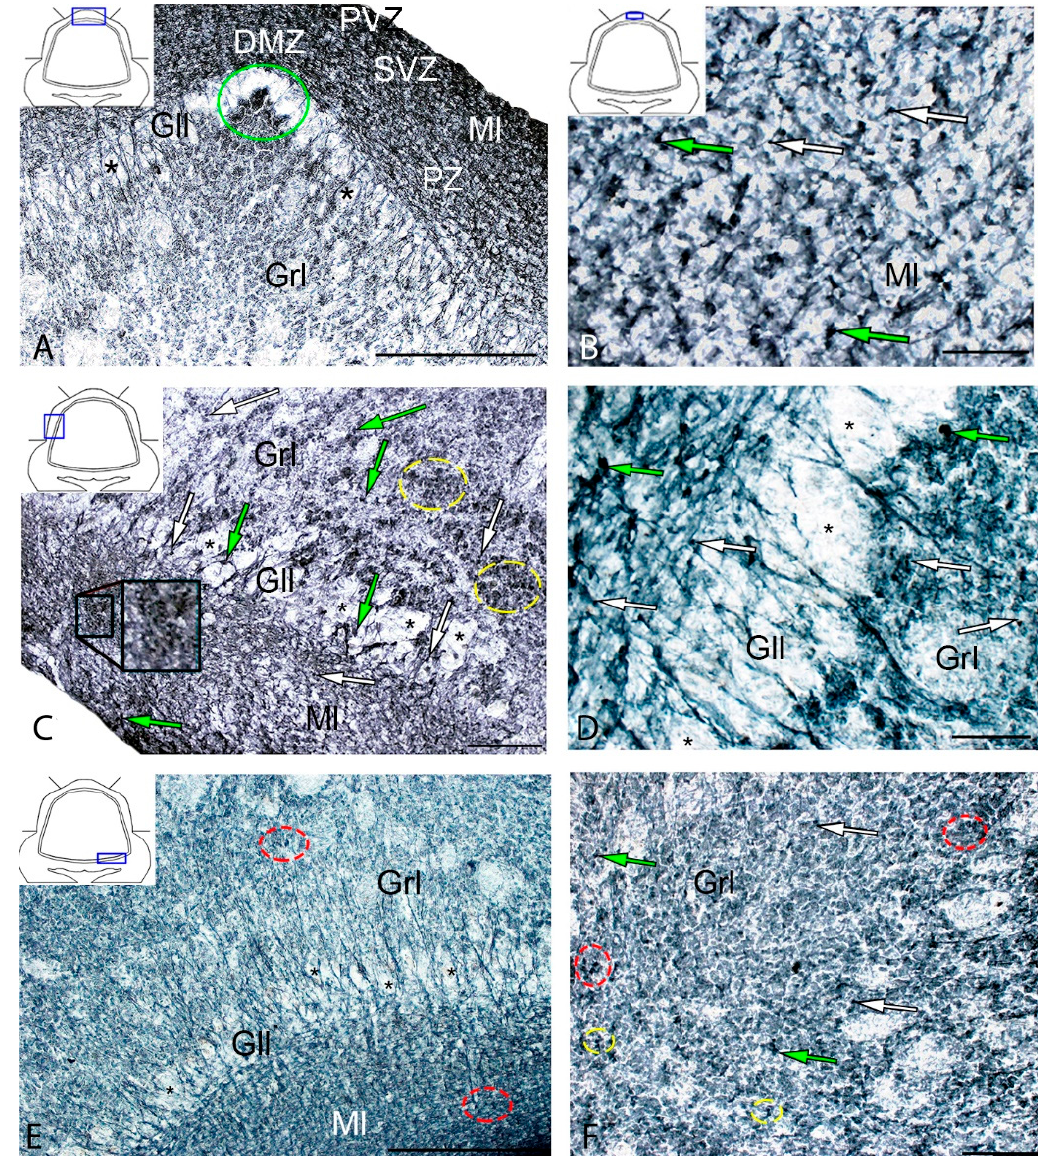
Figure 11. Distribution of cystathionine- β -synthase (CBS) in the intact cerebellum of juvenile masu salmon, Oncorhynchus masou . ( A ) General view of DZ: CBS − cells are indicated by asterisks; DZM is outlined by green oval. ( B ) DZ, molecular layer: CBS + type 1 cells (white arrows); CBS + type 2 cells (green arrows); periventricular zone (PVZ), subventricular zone (SVZ), parenchymal zone (PZ). ( C ) LZ, see designations in Figure 11A: aggregation of CBS + cells in the parenchymal part of the molecular layer (black inset); aggregation of CBS + cells in the granular layer (yellow dashed oval). ( D ) Ganglionic layer: CBS − cells are indicated by asterisks, see designations in Figure 11A. ( E ) Basal zone: CBS − cells are indicated by asterisks; clusters of CBS + cells (red dashed oval). ( F ) Granular layer; clusters of CBS + cells (red dotted oval); paired cells (yellow dotted oval). IHC labeling with CBS. The blue rectangle in the pictogram indicates the corresponding area in the micrograph. Scale bars: ( A ) 200 μ m; ( B , D ) 50 μ m; ( C , E , F ) 100 μ m.